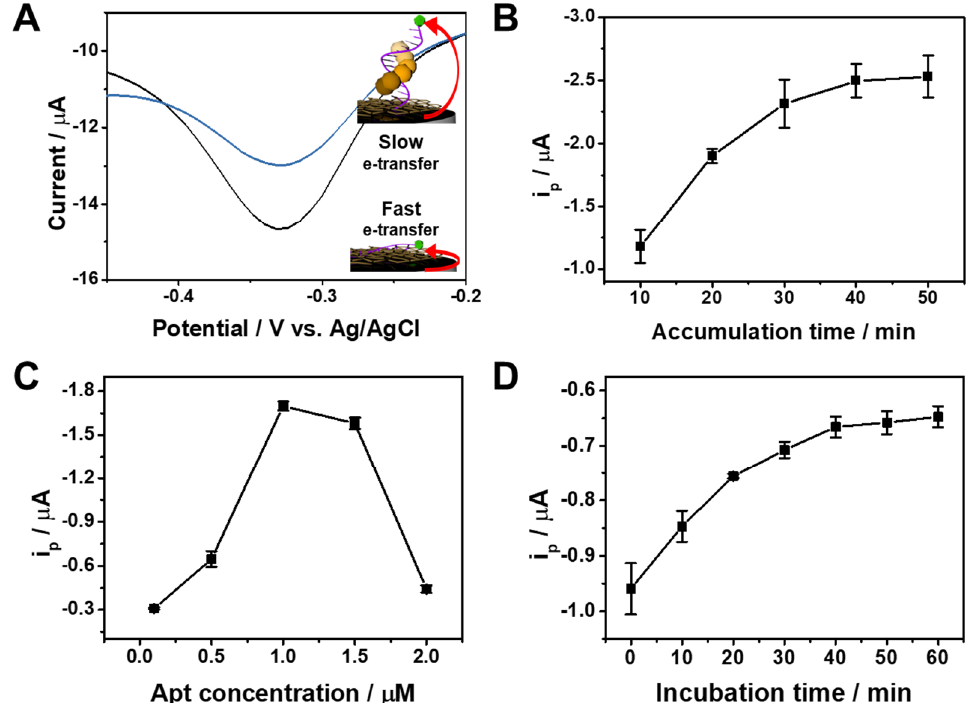
Figure 2. ( A ) Differential pulse voltammetry (DPV) curves of Apt/ERGO-GCE in the absence and presence of α-Syn oligomer in 0.1 M TBS. Effect of ( B ) the accumulation times ([Apt] = 1 μM) and ( C ) Apt concentration (accumulation time = 40 min) for Apt immobilization on i p in 0.1 M TBS buffer. ( D ) Effect of incubation time for α-Syn oligomer binding on i p in 0.1 M TBS buffer. [α-Syn oligomer] = 1 nM, [Apt] = 1 μM, Accumulation time = 40 min, Room temperature.